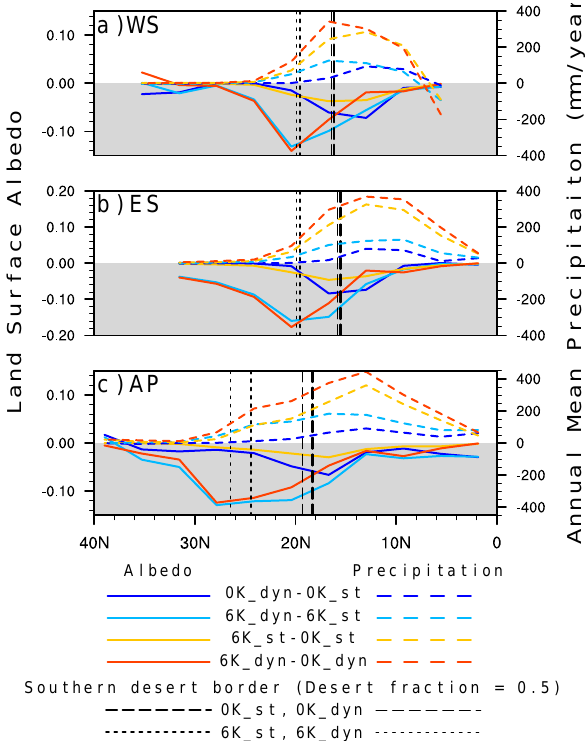
Fig. 5. Change in precipitation (mmyear − 1 ) and albedo averaged zonally over land and over 100 years for the regions (a) WS, (b) ES and (c)